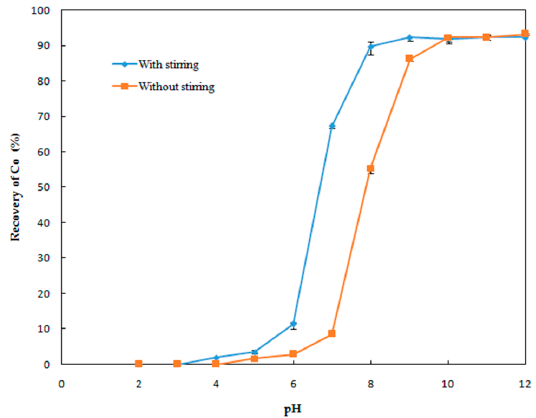
Figure 7. Effect of pH on the recovery of Co.